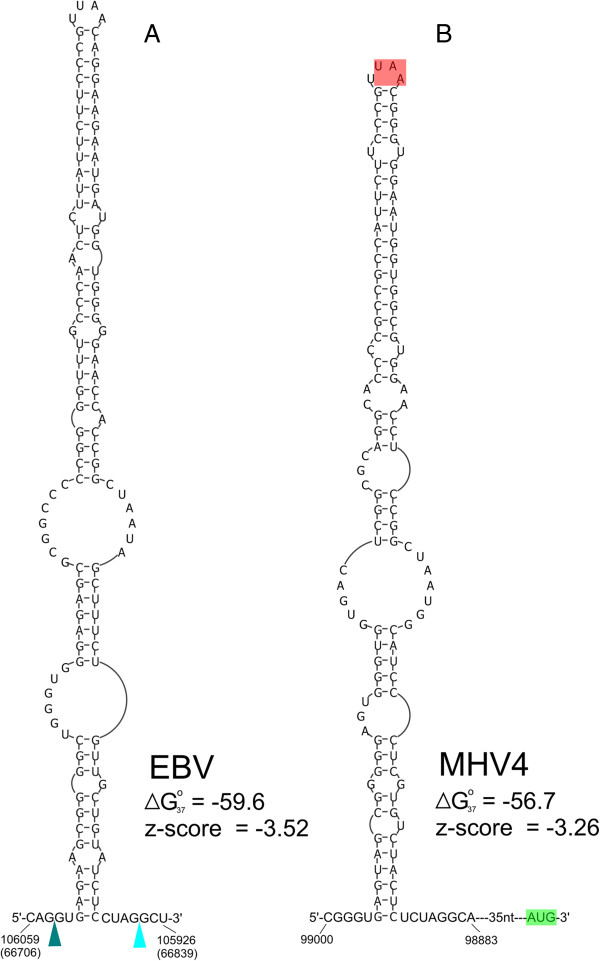
Hairpin structure predicted in BBLF2/3 mRNA. (A) Hairpin modeled for the EBV BBLF2/3 short intron. Splice donor and acceptor sites are indicated with dark and light blue arrows, respectively. Nucleotide numbers in parentheses correspond to the reverse genome strand models in Additional file 3 (locus 152). The predicted free energy (in kcal/mol) and z-score of the hairpin are shown. (B) Homologous hairpin structure in MHV4. The BBLF2 translation stop codon is shaded in red and the BBLF3 start codon is shown in green.